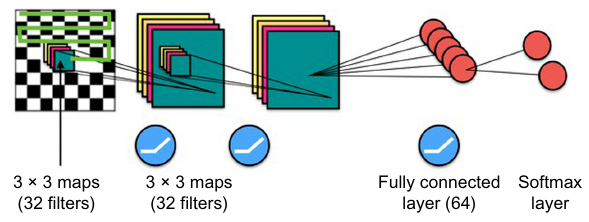
FIG. 2. A convolutional neural network. The elements of the correspond to the outcome of a projective mea- input h ( 0 ) l , j , k surement on the Rydberg system. The first operation is a con- volutional layer with M y × M x = 3 × 3 kernels with I out = 32 output channels and L input = 1. This kernel is convolved with an input configuration with N = 8 × 8 Rydberg atoms. Likewise, the second operation corresponds to a convolutional layer with M y × M x = 3 × 3 kernels with I out = 32 output channels